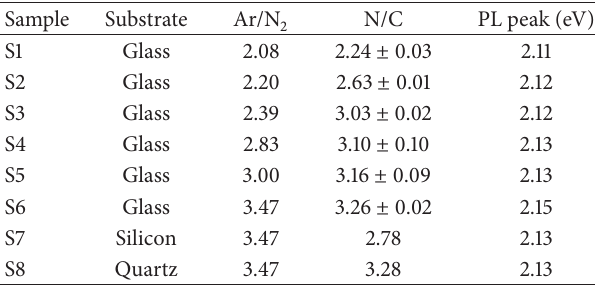
Table 1: Nomenclature, synthesis parameters, and PL results for the CN 𝑥